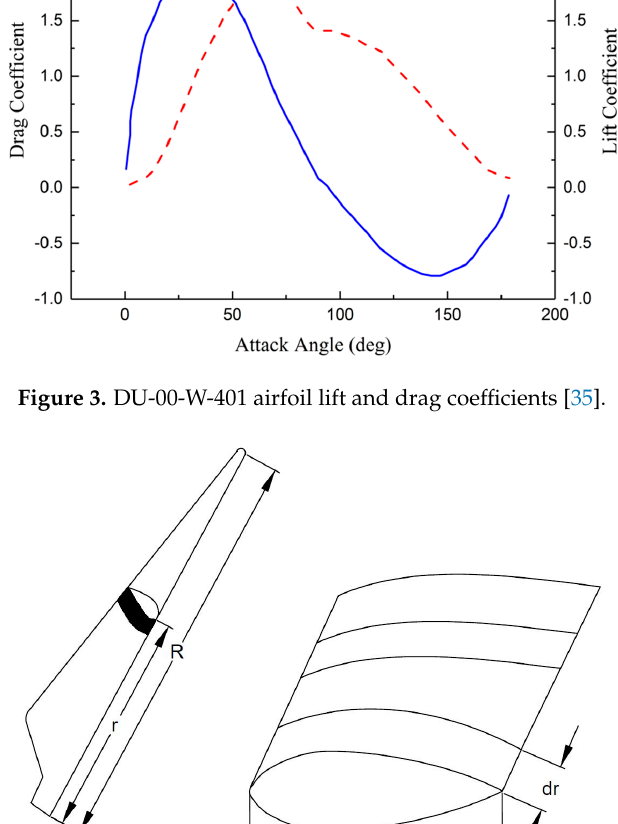
Figure 4. Schematic of the blade with an example airfoil blade element ( r is the distance from blade’s root to airfoil blade element, R is the blade radius, and the chord length is that of the straight line joining the leading and trailing edges of an airfoil).